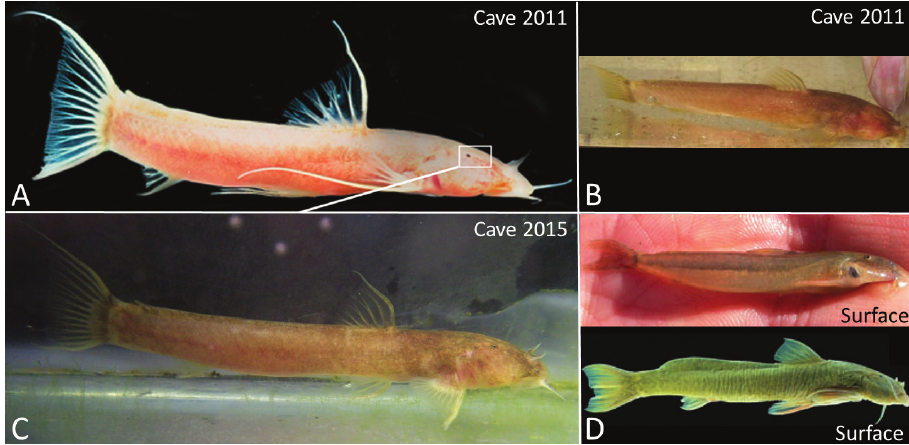
Figure 2. A–C Live specimens of cave Astroblepus pholeter D Two different surface Astroblepus sp. from the Apurimac drainage. Notice contrasting coloration between A and B both of which were collected in 2011. Pigmentation level variability within the cave population in 2011 spanned from pinkish-white white ( A ) to pigmented ( B ) at levels equivalent to some surface Astroblepus ( D ). Specimens collected in 2011 had longer fins ( A ) than those collected in 2015 ( C ). Notice as well that some surface Astroblepus (bottom one in D ) can have small eyes of a size equivalent to cave specimens. A Modified from Haspel et al. (2012) B Modified from the Soares Lab web-page-photo C Specimen collected on 2015 D Modified from Schaefer et al.